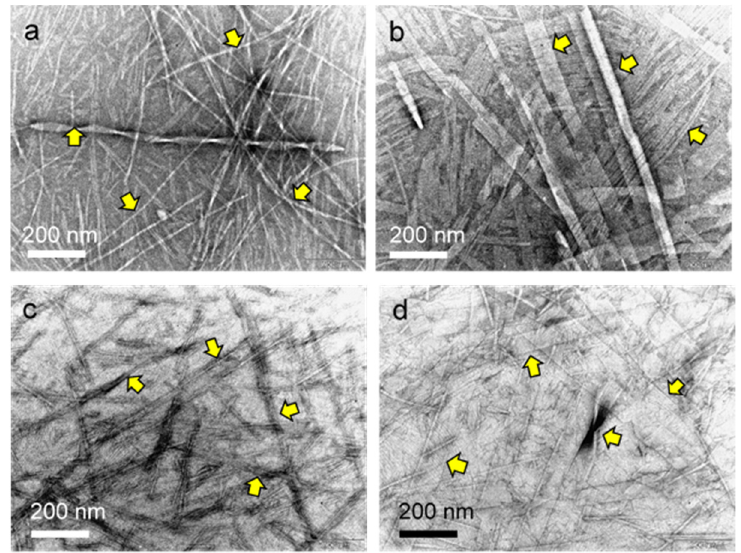
Figure 5. Negative-staining TEM images of the surfactant aqueous solutions at room temperature. Yellow arrows indicate aggregates. Typical images of ( a ) 9-2-2-6 solution, ( b ) 11-2-2-6 solution, ( c ) 13-2-2-4 solution, and ( d ) 13-2-2-6 solution.